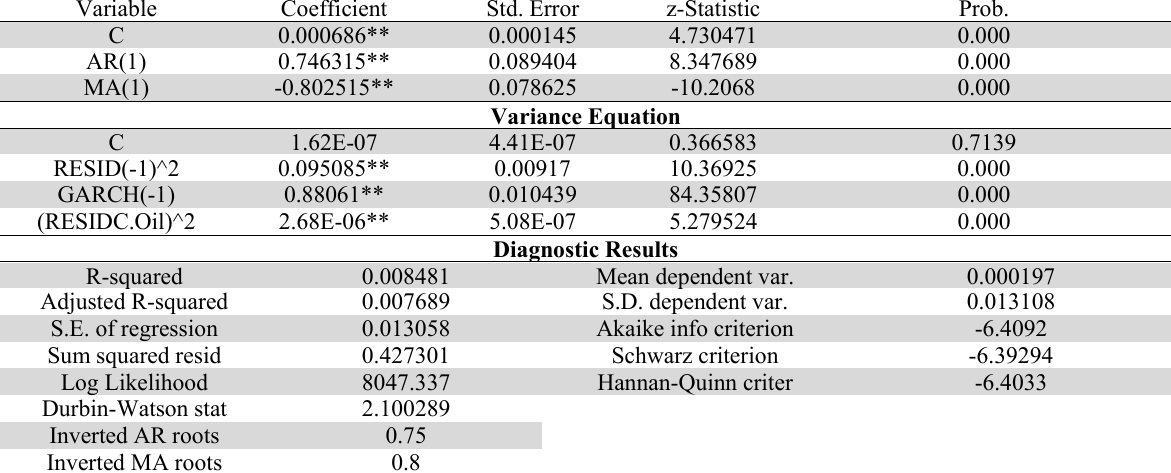
Univariate GARCH – Volatility Spillover Effect (Crude oil to S&P500 index) Variable